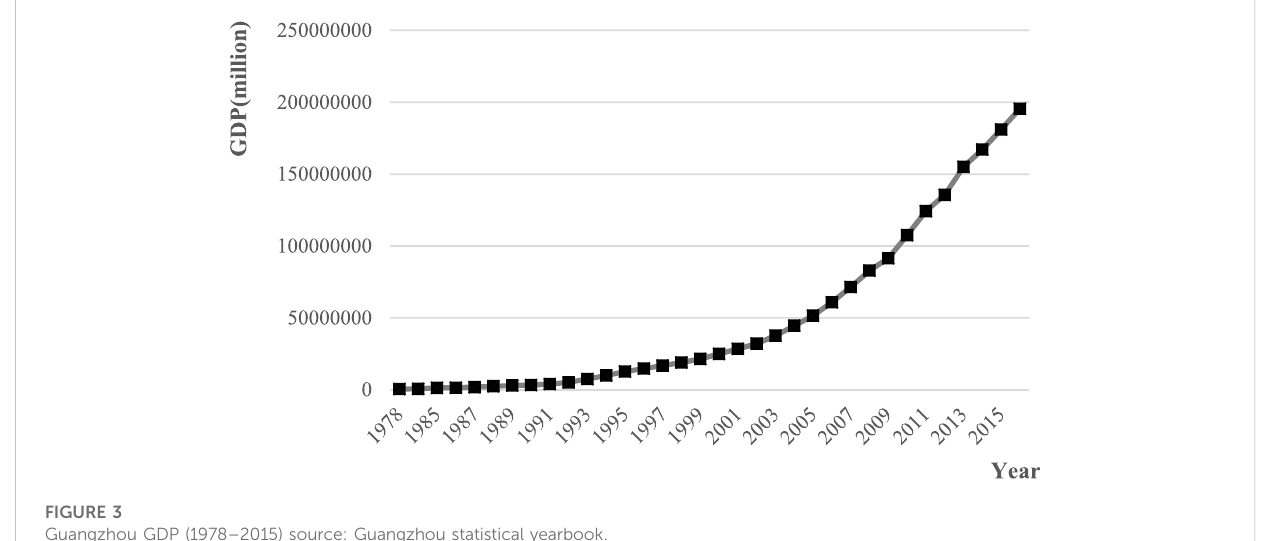
FIGURE 3 Guangzhou GDP (1978 – 2015) source: Guangzhou statistical